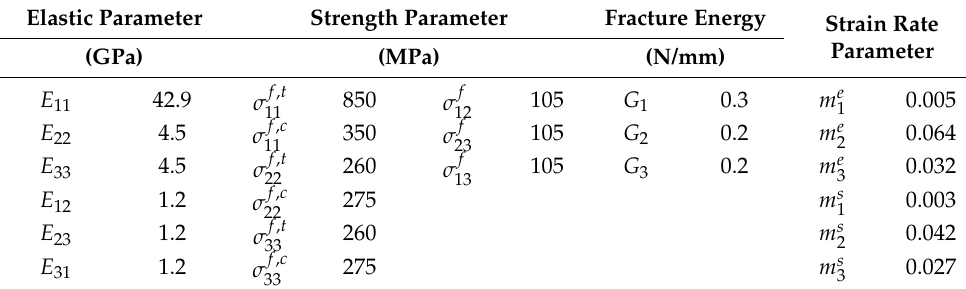
Table 1. Material parameter for QI laminate.